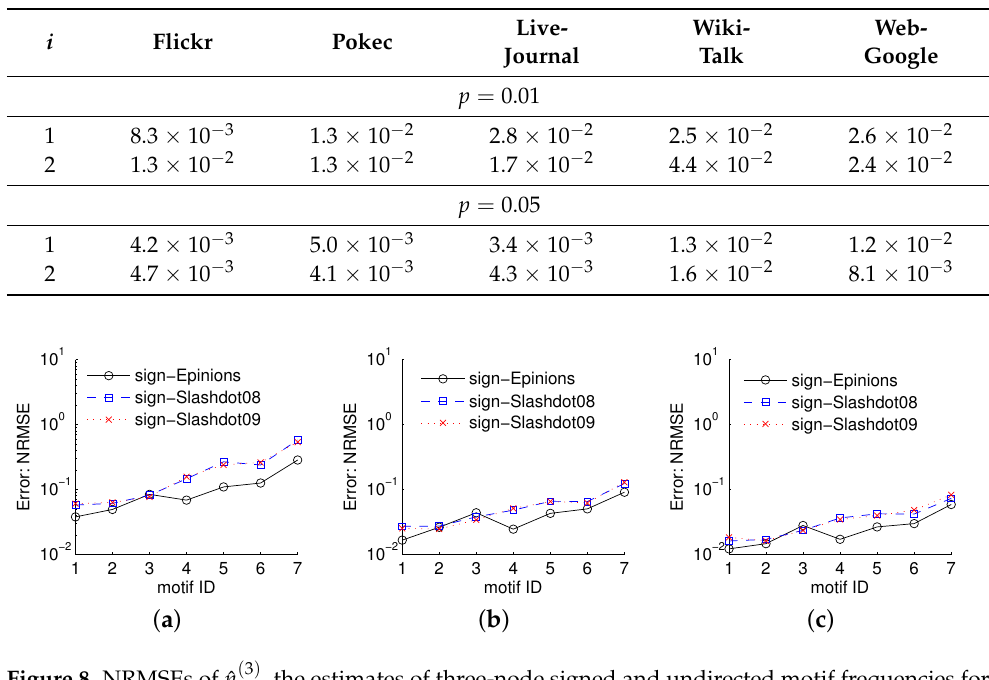
( 3 ) Table 4. NRMSEs of n , the concentration estimates of three-node undirected motifs for p = 0.01 i and p = 0.05, respectively ( i is the motif ID).